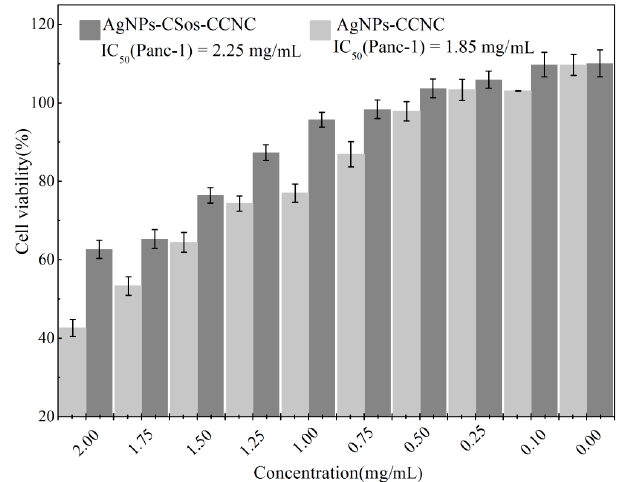
Figure 9. The cytotoxicity of the AgNPs-CSos-CCNC and the AgNPs-CCNC hybrid on Panc-1 cells using the CCK8 assay.